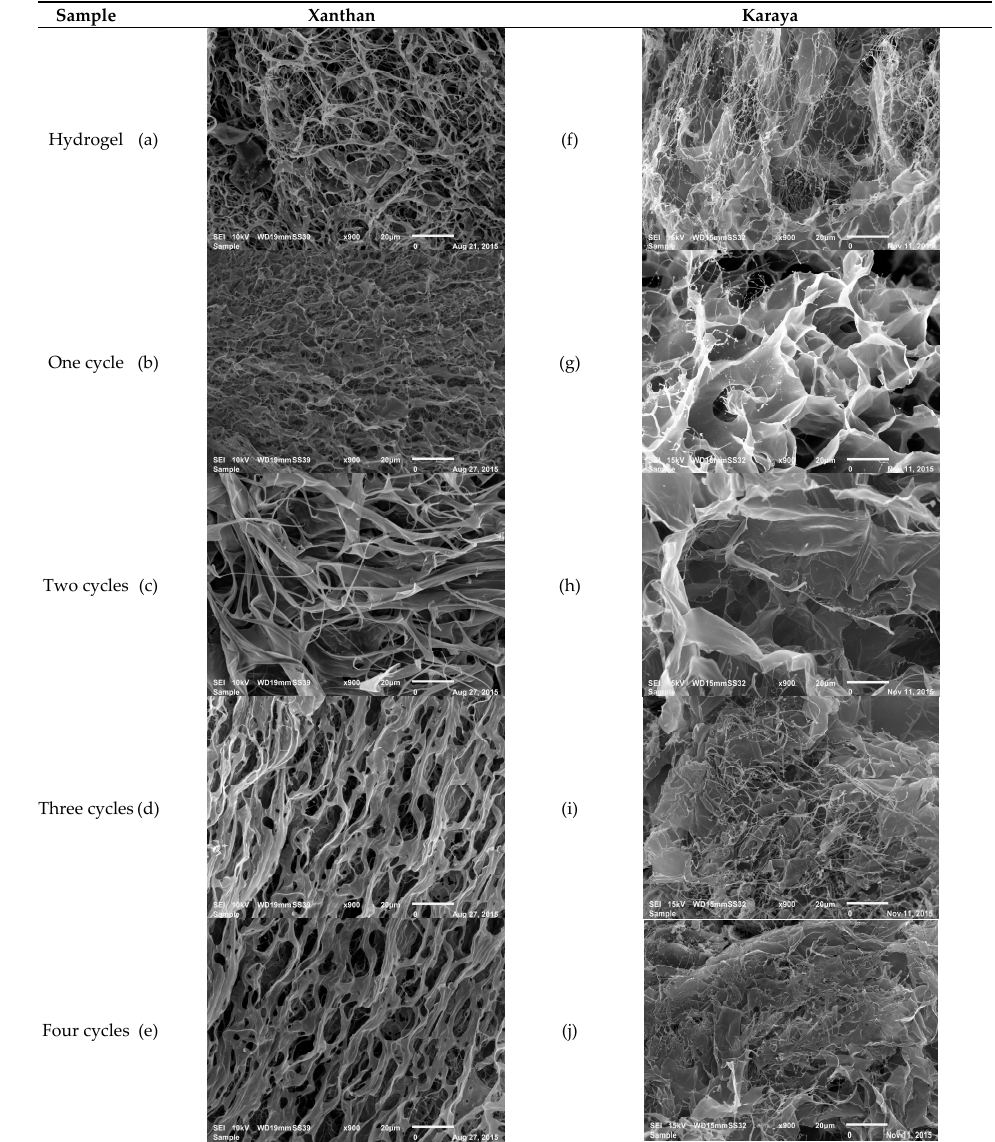
Figure 2 Figure 2. SEM micrographs (900 × ) of the xanthan and karaya hydro- and cryogels. At the third cycle, the structure of the xanthan cryogel was not modified significantly ( p > 0.05), which may be due to the formation of larger molecular assemblies, mainly of union or dimerization crisscrossed (formation of a double coaxial helix), which promoted the rearrangement of the polymeric chains reaching their highest degree of conformational ordering. Thus, more homogeneous pores were observed (Figure